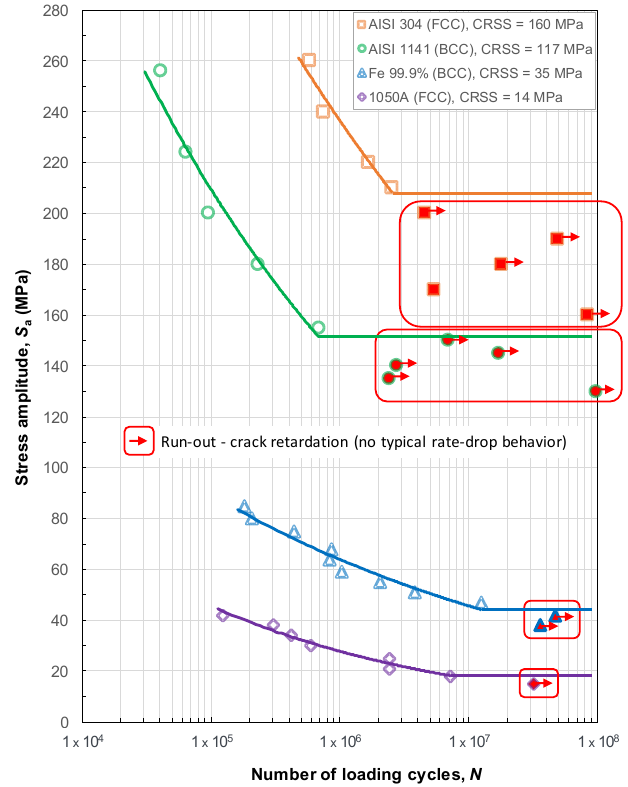
Figure 7. Simulation-based fatigue life curves, which illustrate the existence of definite fatigue limits in BCC and FCC materials depending on the magnitudes of the CRSS.